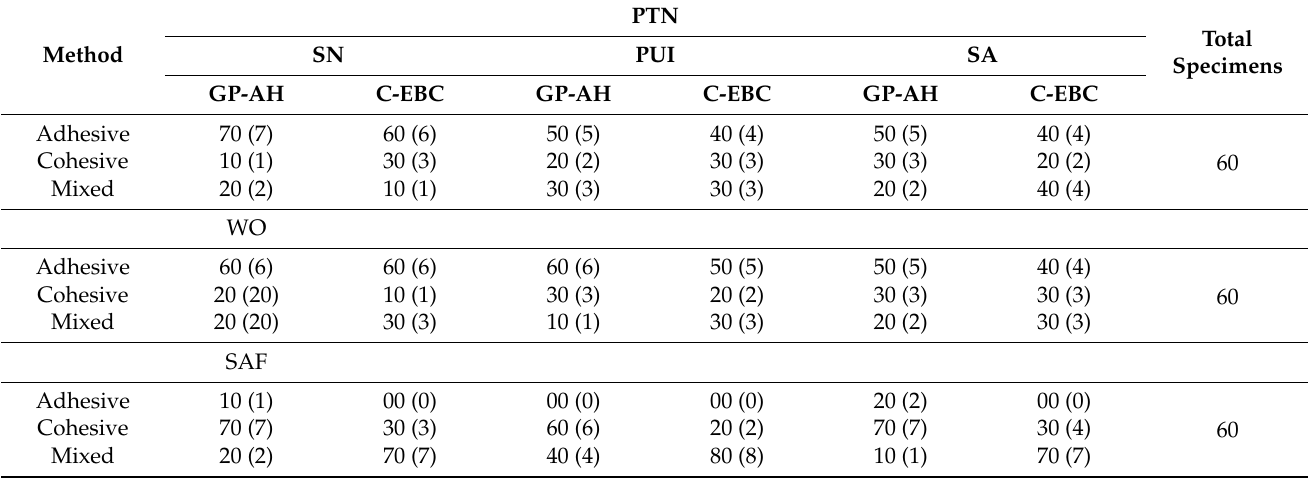
Table 2. Modes of failure in percentage and number of samples (n) after push-out bond strength test of root